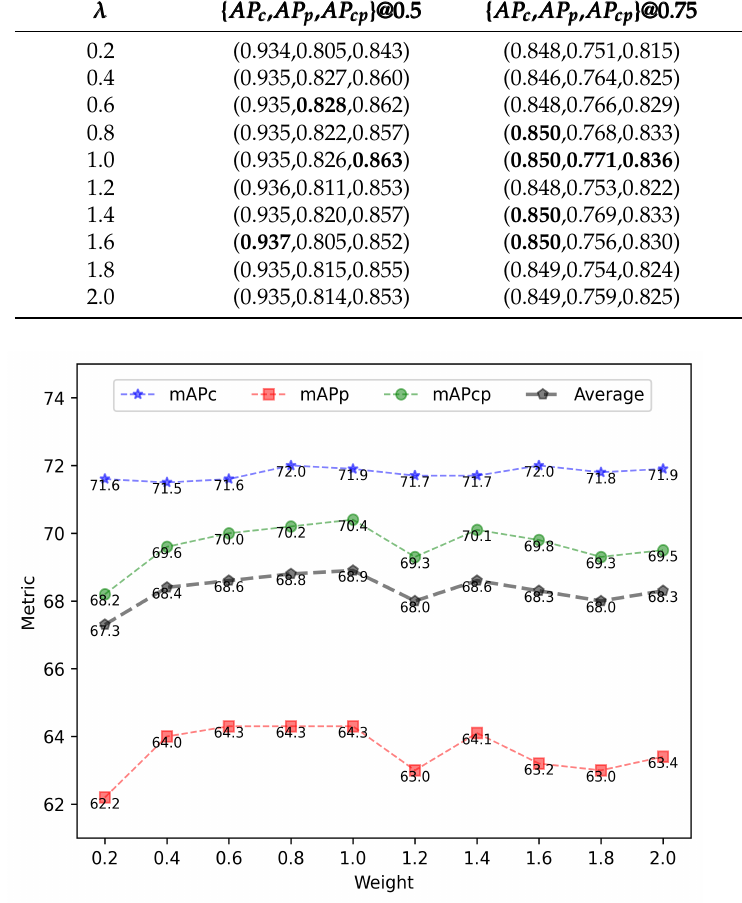
Figure 10. Illustration of trends in the values and means of the three indicators relative to the weighting coefficient for the loss of predicting human posture on the IPHPDT